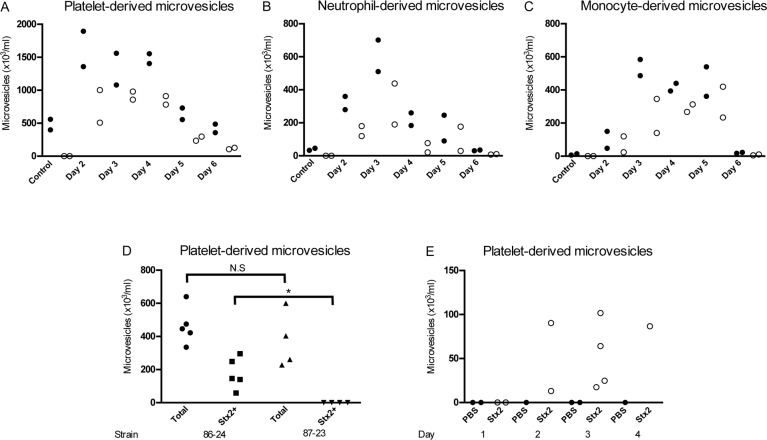
Stx2-containing blood cell-derived microvesicles were detected in the circulation of mice infected with E. coli O157:H7.Microvesicles were isolated from whole blood of BALB/c mice (n = 10) inoculated with the Stx2-producing E. coli O157:H7 strain and analyzed by flow cytometry. Samples were taken between days 2 and 6 after infection. Microvesicles were labeled with anti-Stx2 and anti-mouse CD41:APC (A) to identify platelet-derived microvesicles, anti-mouse Ly-6G:PE (B) to identify neutrophil-derived microvesicles or a combination of anti-mouse CD45R/B222:PerCp-Cy5.5 and anti-mouse Ly-6G:PE (C) to identify monocyte-derived microvesicles. All microvesicles were labeled with cell-specific and Stx2 antibodies. Stx2-containing microvesicles were mostly detected on days 2–5 after infection. No labeling of the Stx2 antibody was detected in the non-infected mice (n = 2, day 6). (D) Platelet-derived microvesicles (labeled with anti-mouse CD41:APC) and stained for Stx2 were isolated from mice inoculated with Stx2-producing E. coli O157:H7 strain 86–24 and the isogenic non-Stx producing E. coli O157:H7 strain 87–23 on day 3 post-inoculation. Only mice inoculated with strain 86–24 exhibited Stx within microvesicles. * Denotes P<0.05. (E) Platelet-derived microvesicles labelled for Stx2 were isolated from mice injected with Stx2 i.p. or PBS controls. An increase in microvesicles was noted in Stx-treated mice 3–4 days after treatment.